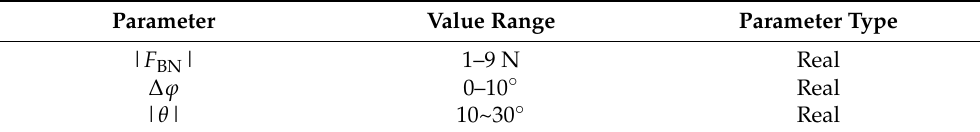
Table 1. Design space of approximate models.